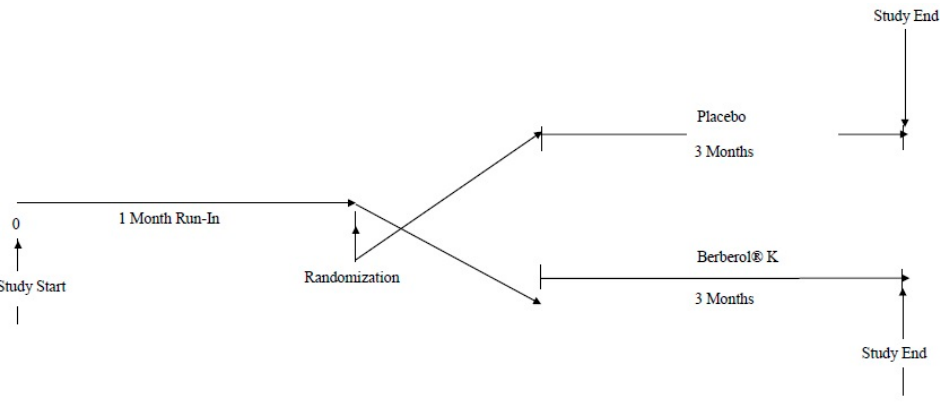
Figure 1. Study design.